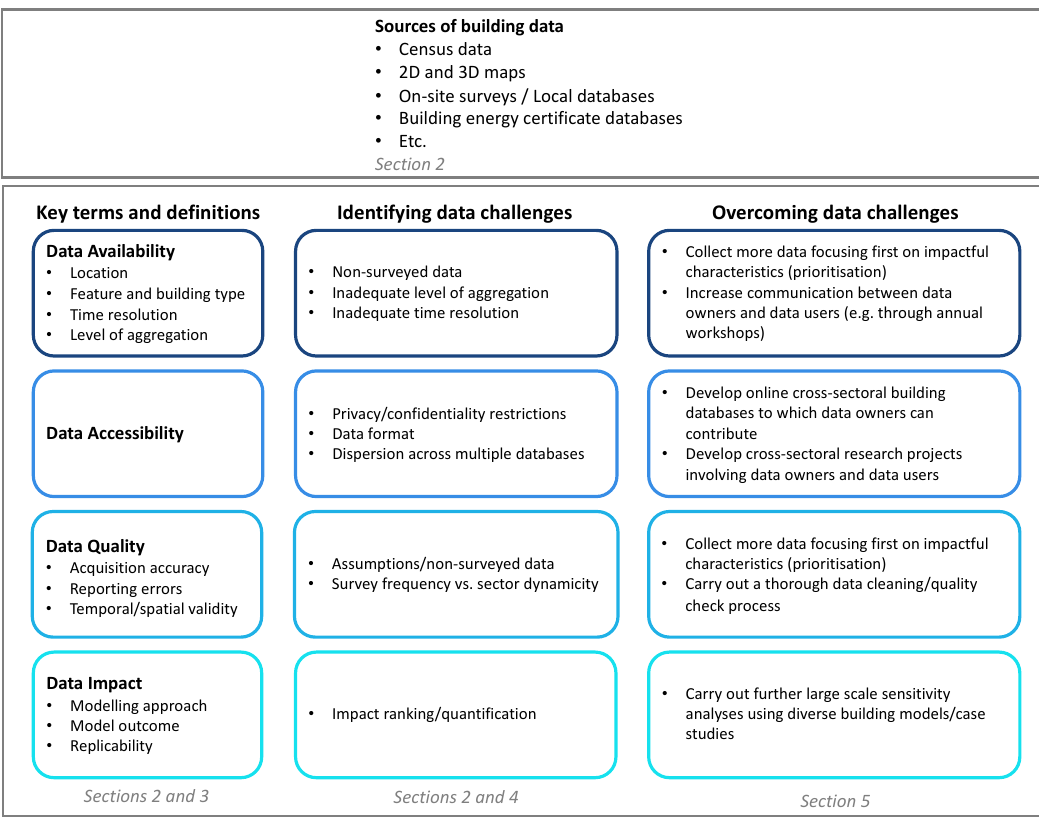
Figure 1. Key terms, challenges and solutions addressed in the paper.